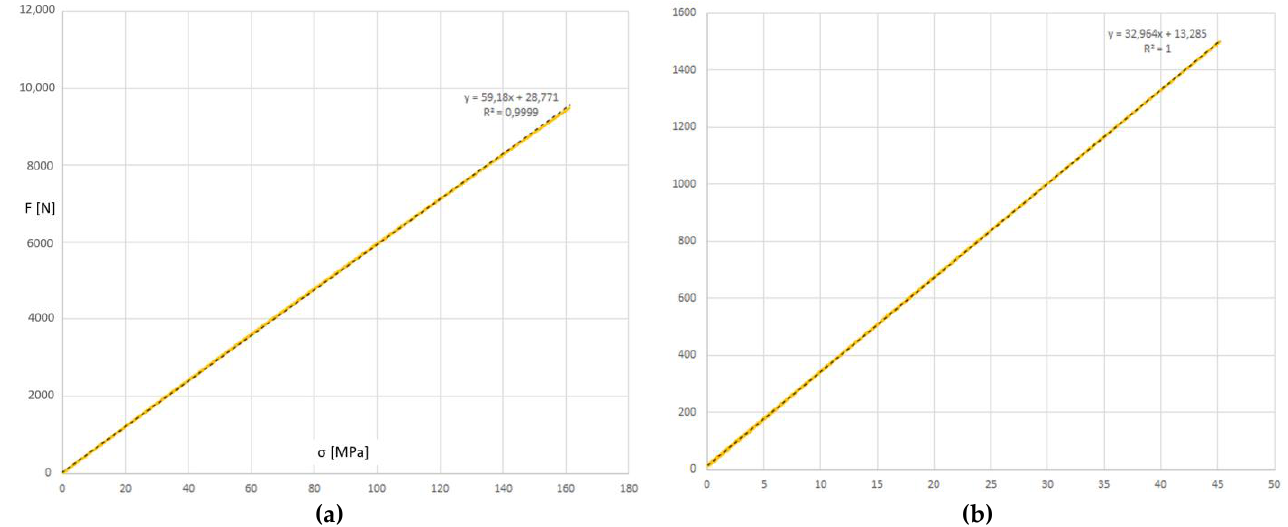
Figure 3. Exact buckle plate calibration curve: ( a ) curve related to baseplate PS22040-1 and ( b ) curves related to baseplate PS